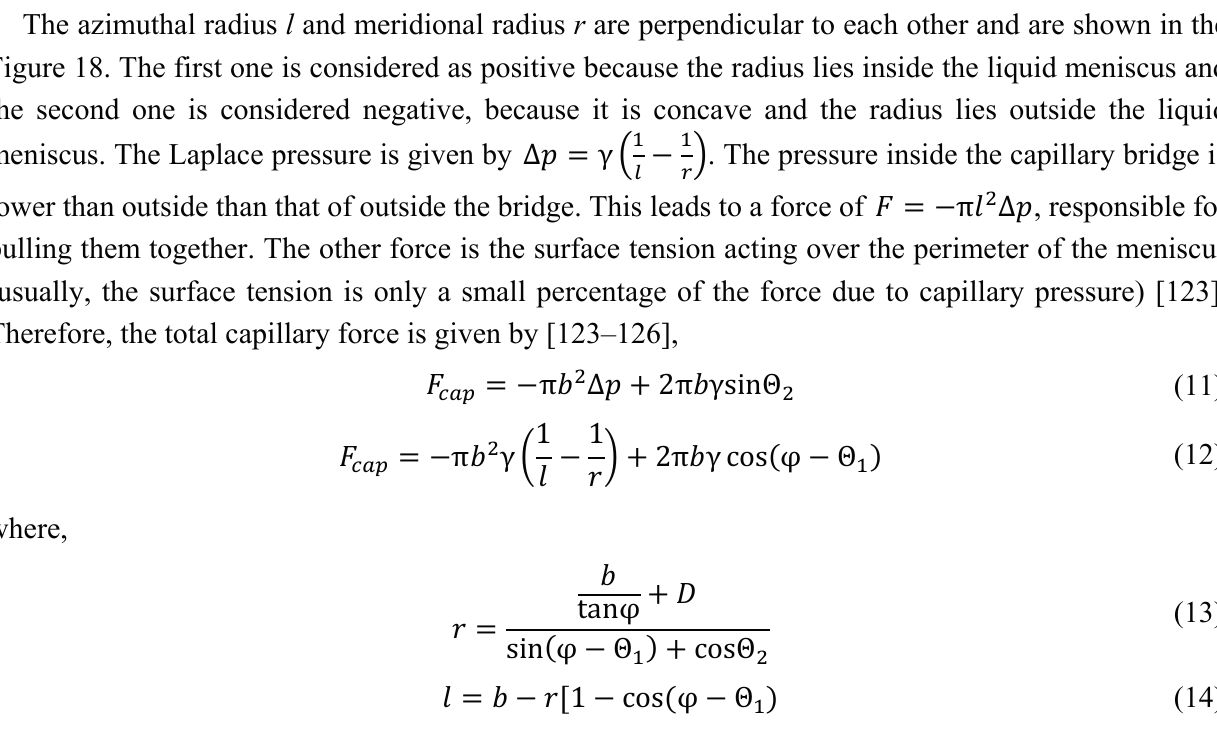
Figure 18. Schematic of a liquid bridge responsible for the capillary force between the tip and the